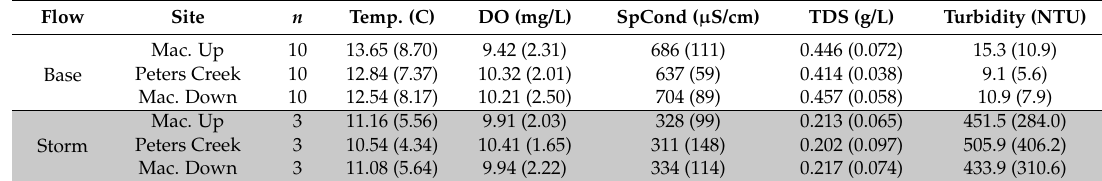
Table 2. Mean (1 Standard Deviation (SD)) values of water quality parameters at the Middle Macatawa wetland restoration site during the 2017 postrestoration sampling year (Dec. 2016–Nov. 2017). Storm flow data shown in gray